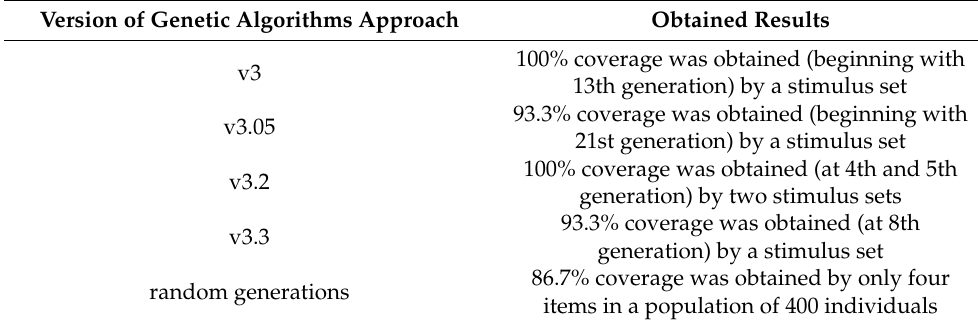
Table 3. Results for ALU when values of result were split in 15 ranges.